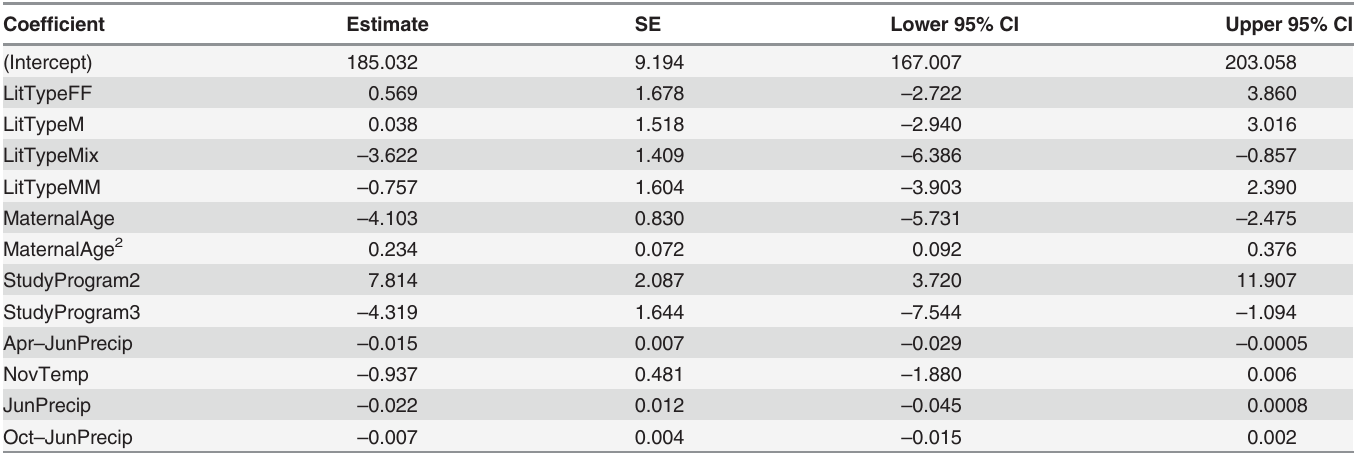
Table 3. Parameter estimates utilizing restricted maximum likelihood estimation for a linear mixed-effects model assessing the influence of bio- logical (litter type, maternal age, and study program) and environmental factors on parturition date (Julian date) of singleton and twin white-tailed deer at Kerr Wildlife Management Area, Kerr County, TX from 1977 –